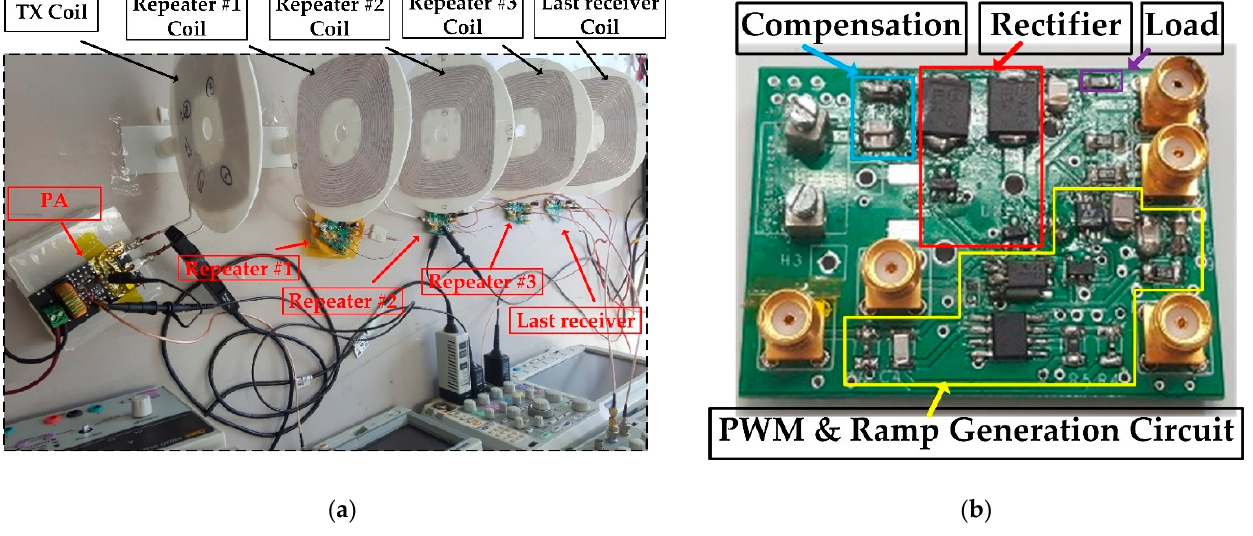
Figure 9. Experimental setup ( a ) Repeater and ( b ) receiver circuit.